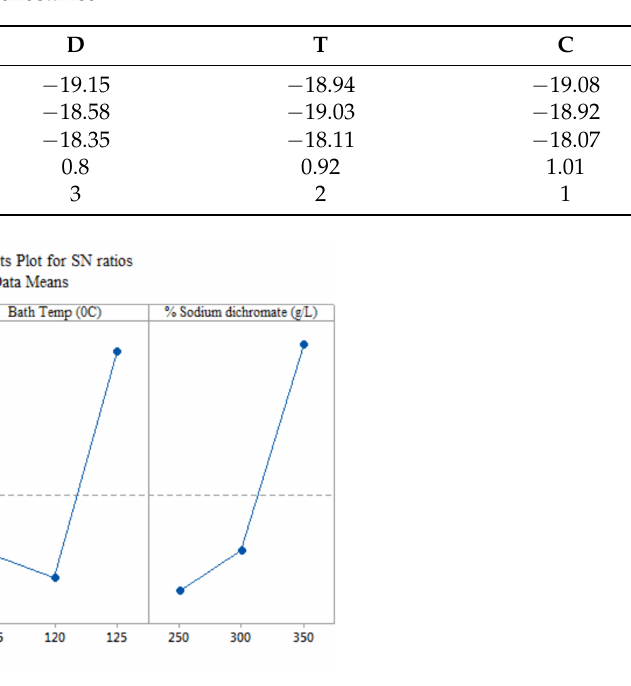
Figure 2. Mean effect plot for reflectance(R).